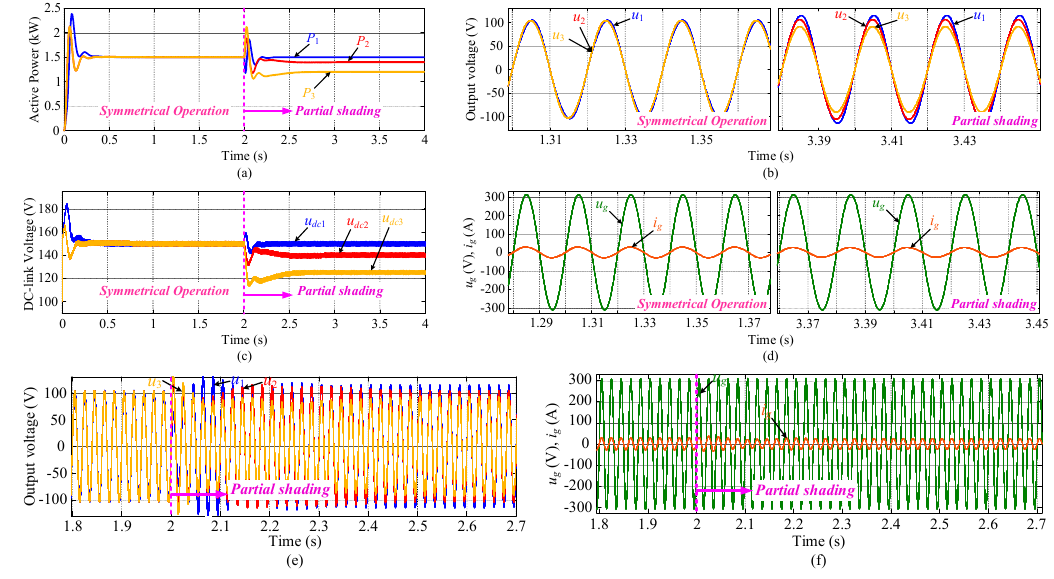
Figure 6. Simulation results under symmetrical condition and partial shading condition. ( a ) Active power; ( b ) Steady-state output voltages; ( c ) DC-link voltages; ( d ) Grid voltage and line current in steady state; ( e ) Output voltages in transient state; ( f ) Grid voltage and line current in transient state.